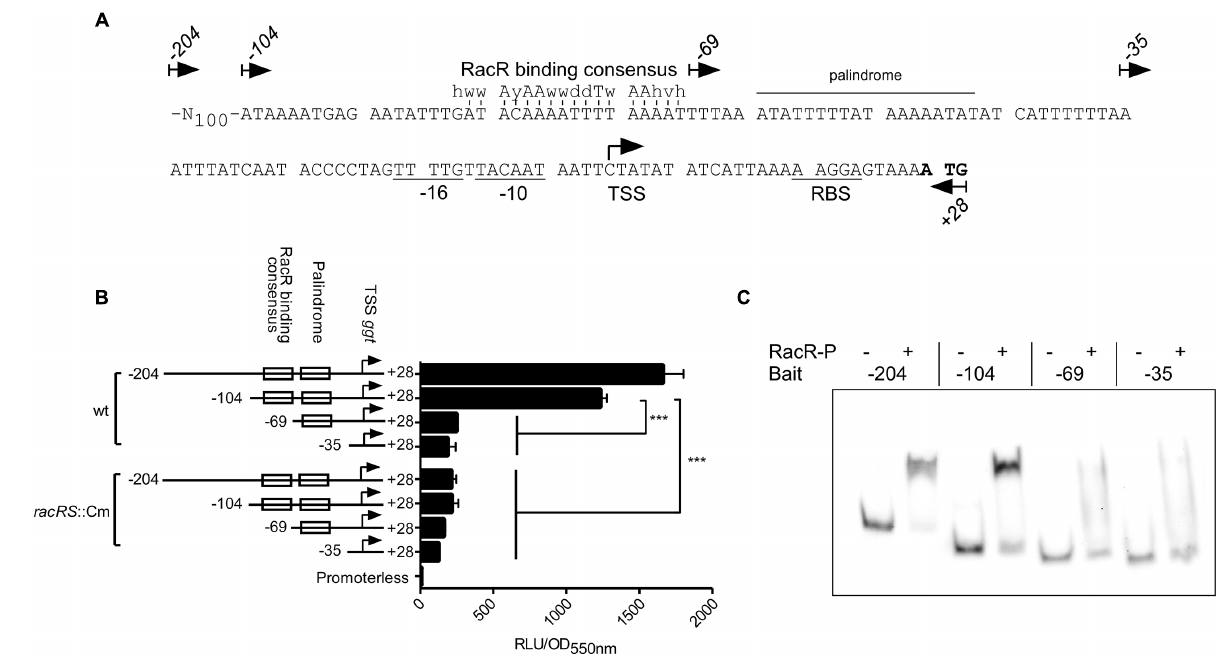
bait DNA. The transcriptional start site of the ggt gene identified by (Dugar et al., 2013) is indicated with a hooked arrow. (B) Luciferase activities using different lengths of the region upstream of the ggt gene are determined in wt and racRS ::Cm mutant bacteria. Cultures were grown until late-log phase at oxygen limiting conditions with the addition of nitrate. Data represents the mean and SE of three independent experiments. (C) EMSA experiments using the different ggt promoter elements. DIG-labeled PCR fragments ( ∼ 50 fmol) were mixed with or without 50 pmol RacR and 25 pmol RacScyto in the presence of ATP. RacR-P phosphorylated